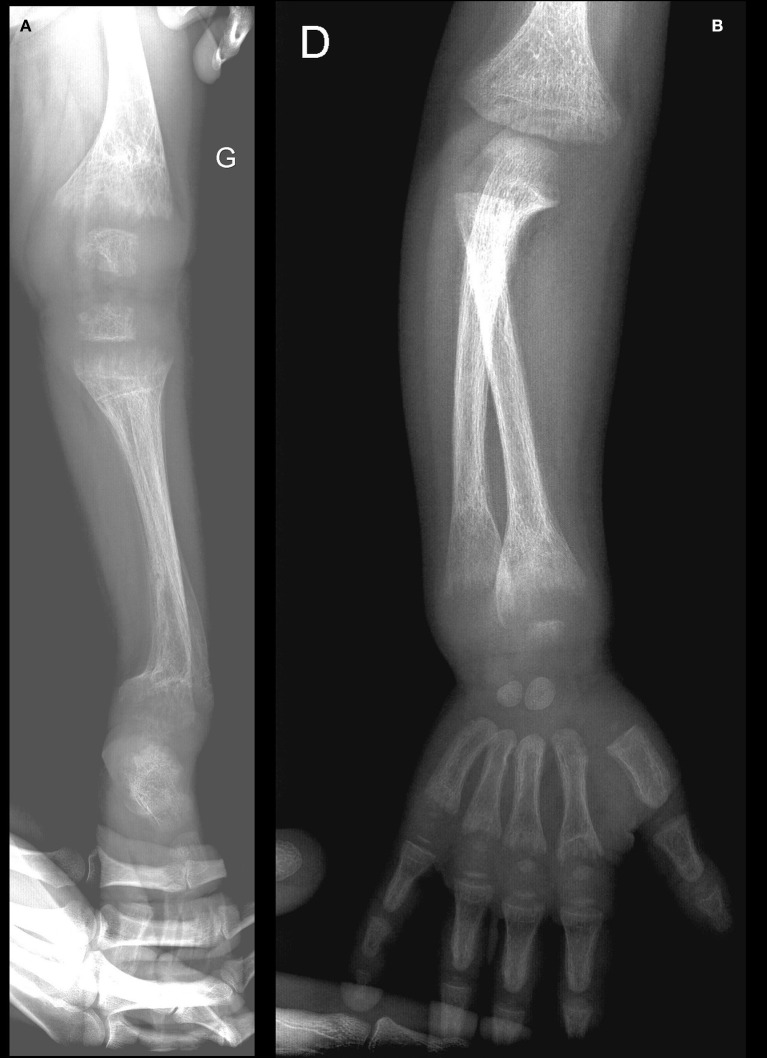
(A,B) Rachitic changes of the lower (A) and upper (B) extremity bones (at diagnosis).